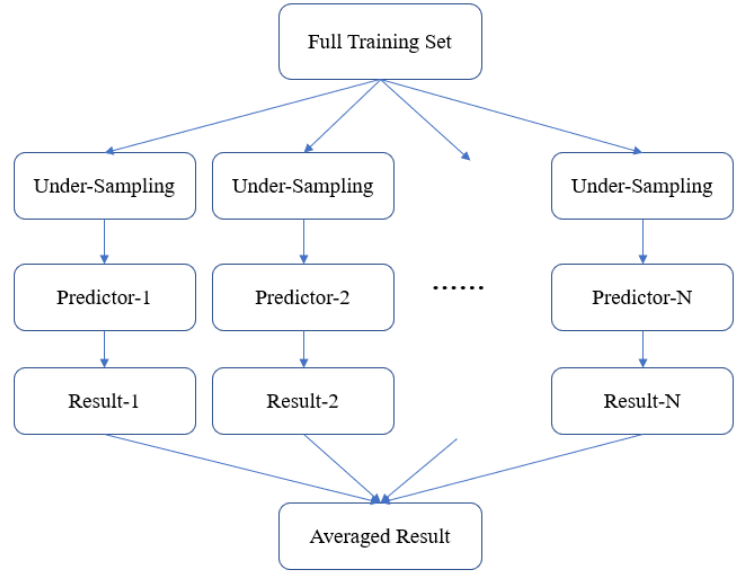
Figure 7. Process of model